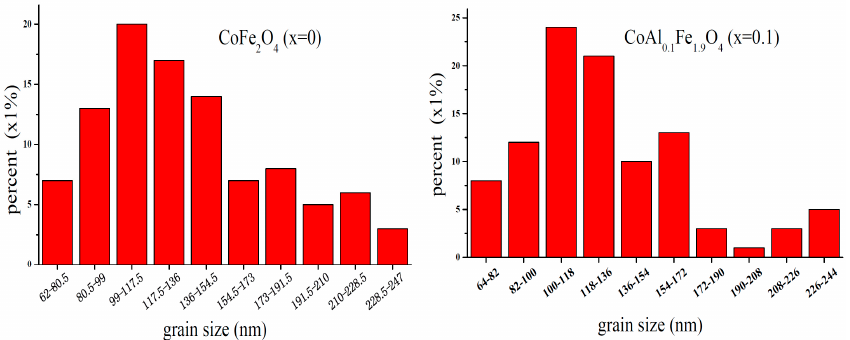
Figure 5. Histogram of grain-size distribution for CoFe 2 O 4 ( x = 0) and CoAl 0.1 Fe 1.9 O 4 ( x = 0.1), which were calcined at 1000 °C.